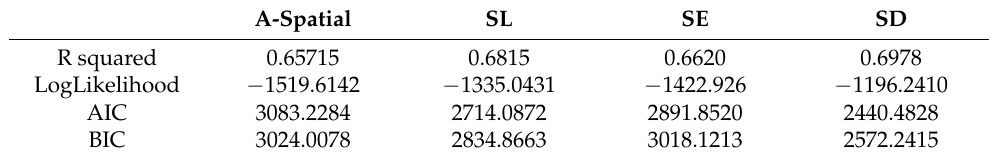
Table 6. Goodness-of-fit measures for a-spatial and spatial-PD-STIRPAT models.